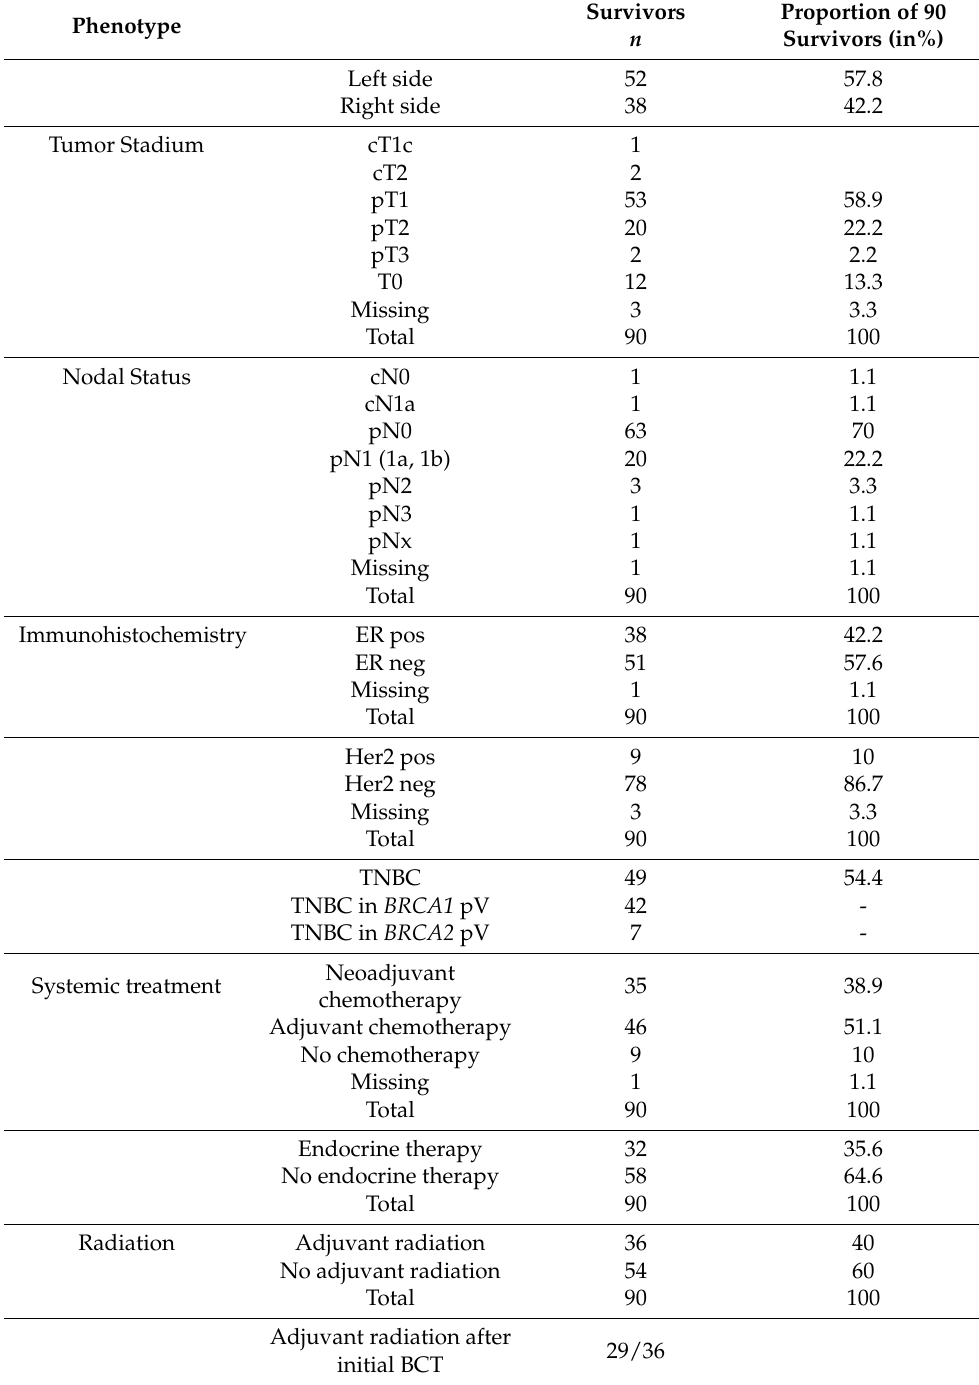
Table 2. Tumor phenotype and therapy of the 90 survivors with pV in BRCA1/2. Legend: c: clinical, ER: estrogen receptor, Her2: Human epidermal growth factor receptor 2, N: nodes, T: tumor, TNBC: triple-negative breast